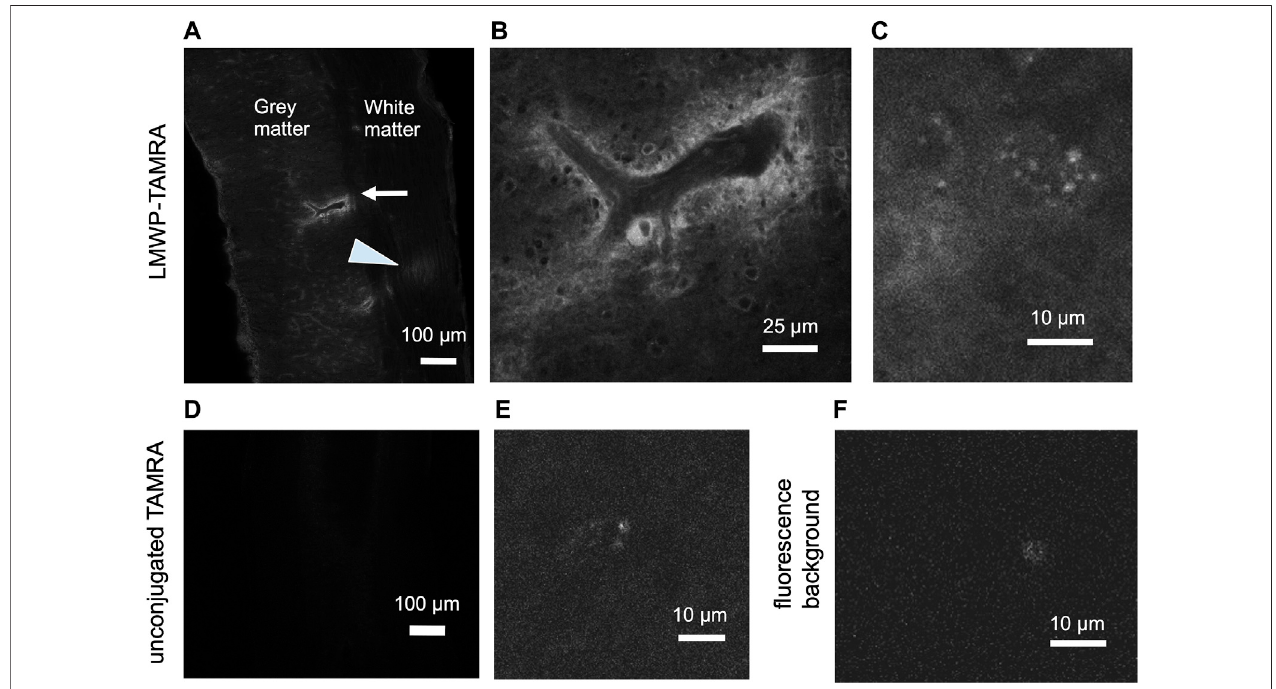
FIGURE 8 | Subcutaneous injection of the fl uorescently labelled LMWP results in the fl uorescent signal accumulation in the spinal cord parenchyma. (A) A longitudinalspinalcordsection,cervicalregion,2 haftertheTAMRA-LMWPinjection.PerivascularaccumulationofTAMRA-LMWPismarkedwithanarrow.Fluorescent fi ber labeling in white matter is shown with an arrowhead. (B) Enlarged view of the perivascular accumulation of TAMRA-LMWP shown in (A) . (C) Parenchymal accumulation of TAMRA-LMWP. (D,E) The cervical spinal cord parenchymal fl uorescence 2 h after the unconjugated TAMRA injection used as a control [ (D) low magni fi cation, (E) high magni fi cation]. (F) Fluorescence background in the uninjected mouse spinal cord. The scale bar in (A,D) is 100 µm, in (B) 25 µm, in (C,E,F) 10